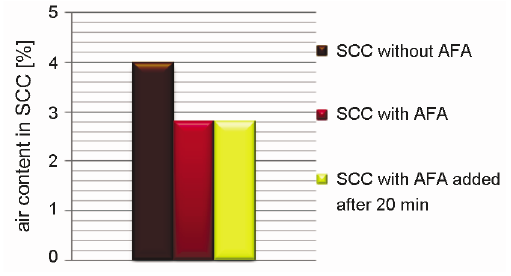
Fig. 8. The influence of AFA on air-content in